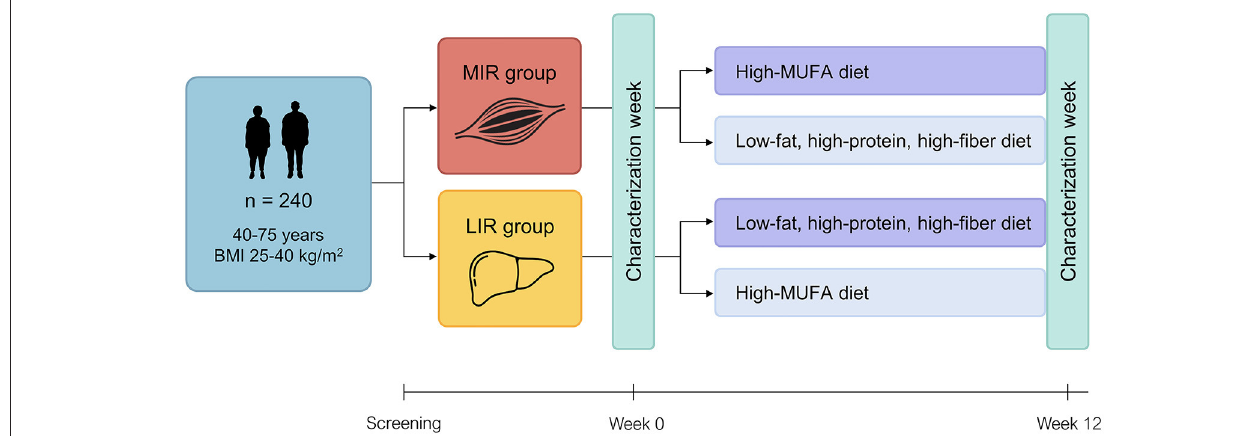
FIGURE 1 | Study design of the PERSON study. Tissue-specific insulin resistance (MIR, muscle insulin resistance; LIR, liver insulin resistance) is assessed at screening using a 7-point oral glucose tolerance test and eligible participants with MIR or LIR are randomized to follow either their hypothesized optimal (dark purple) or suboptimal (light purple) diet for 12 weeks. Before and after the intervention, participants are extensively phenotyped during a “characterization week” in a controlled laboratory setting as well as in daily life. BMI, body mass index; MUFA, monounsaturated fatty